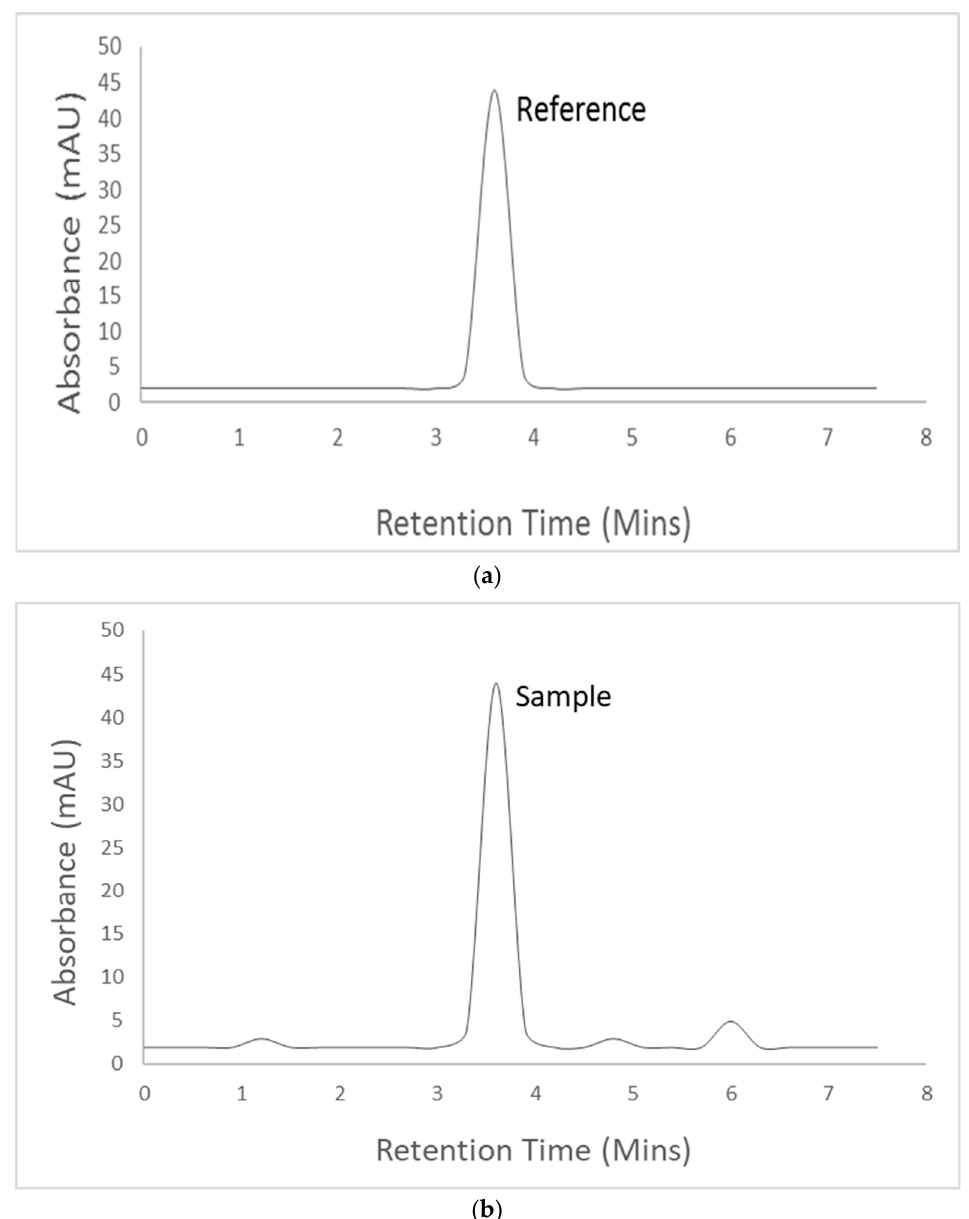
Figure 5. FTIR spectrum of biovanillin.